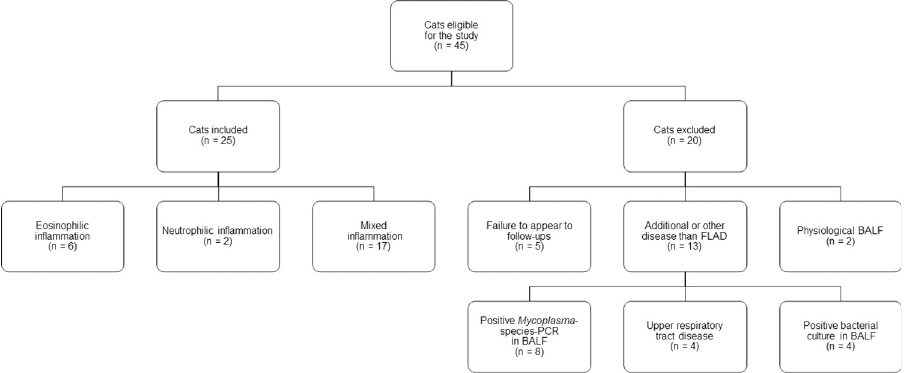
Fig 1. Flow chart for selection and grouping of study